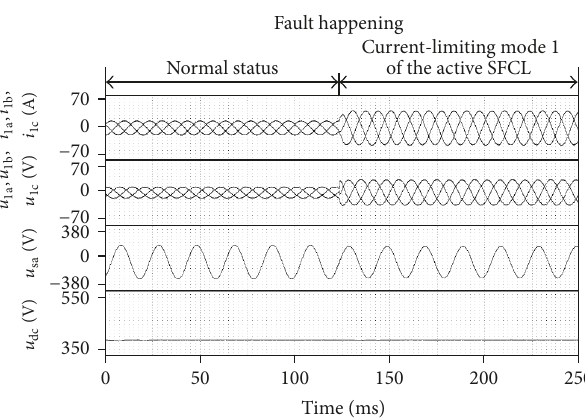
Figure 9: Influence of adjusting the capacitor voltage on the active SFCL prototype under the commissioning test. (a) 𝑢 𝑢 = 80 V. dc